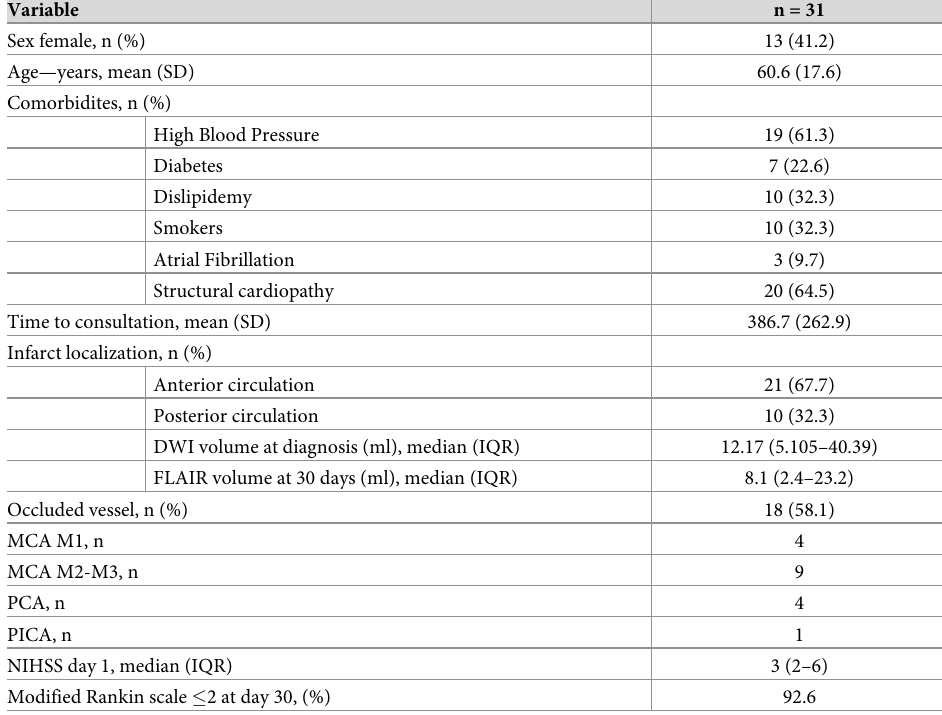
Table 1. Clinical characteristics of stroke patients. MCA M1 = M1 Segment of the middle cerebral artery; PCA = Posterior cerebral artery; PICA = Postero-inferior cerebellar artery. Variable